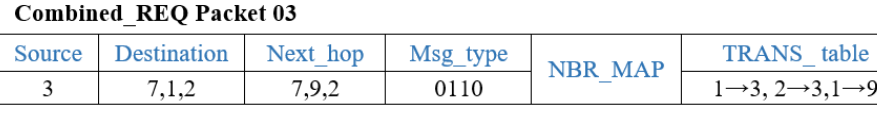
Figure 11. Combined request packet of N 3